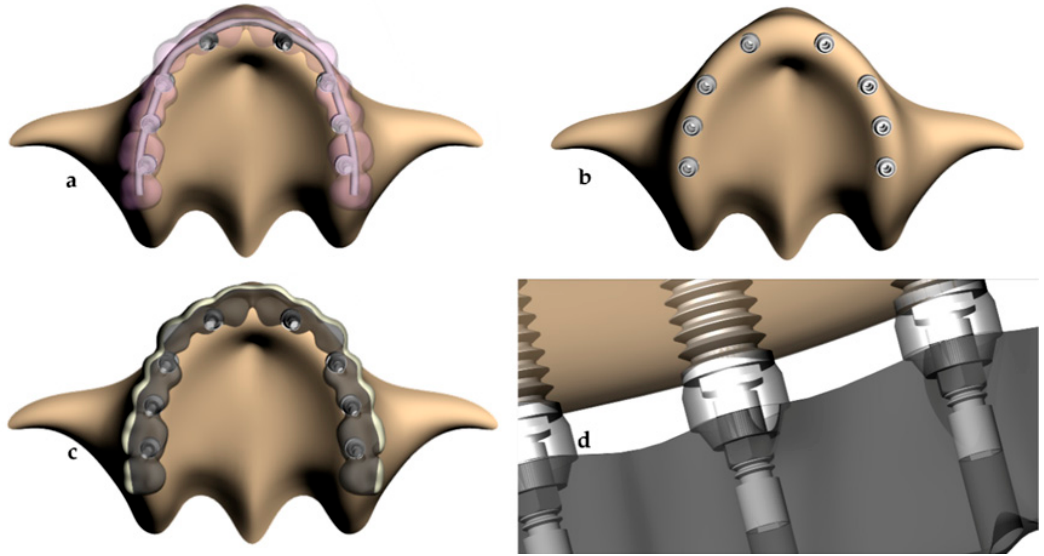
Figure 2. ( a – d ) Schematic illustration of the modeling based on the clinical parameters. ( a ) Conventional design based on a casted CoCr framework and acrylic